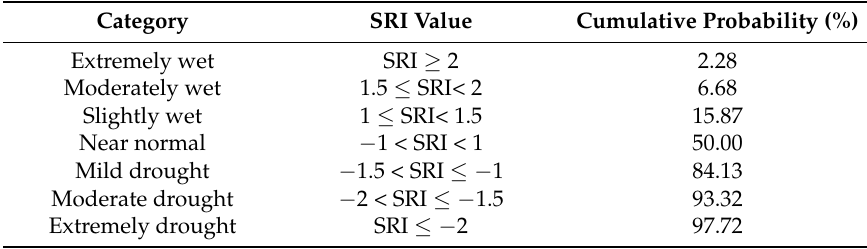
Table 1. Standardized Runoff Index (SRI) classification and corresponding cumulative probabilities of occurrence.